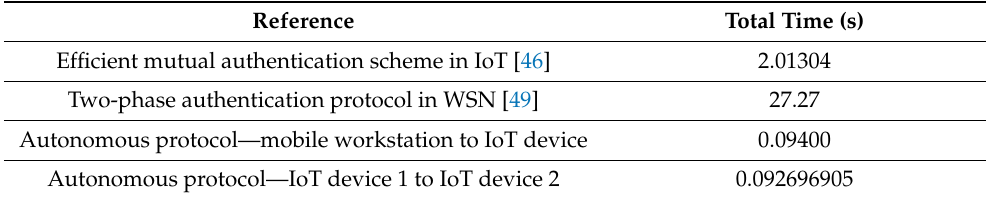
Table 8. Total time for the protocol